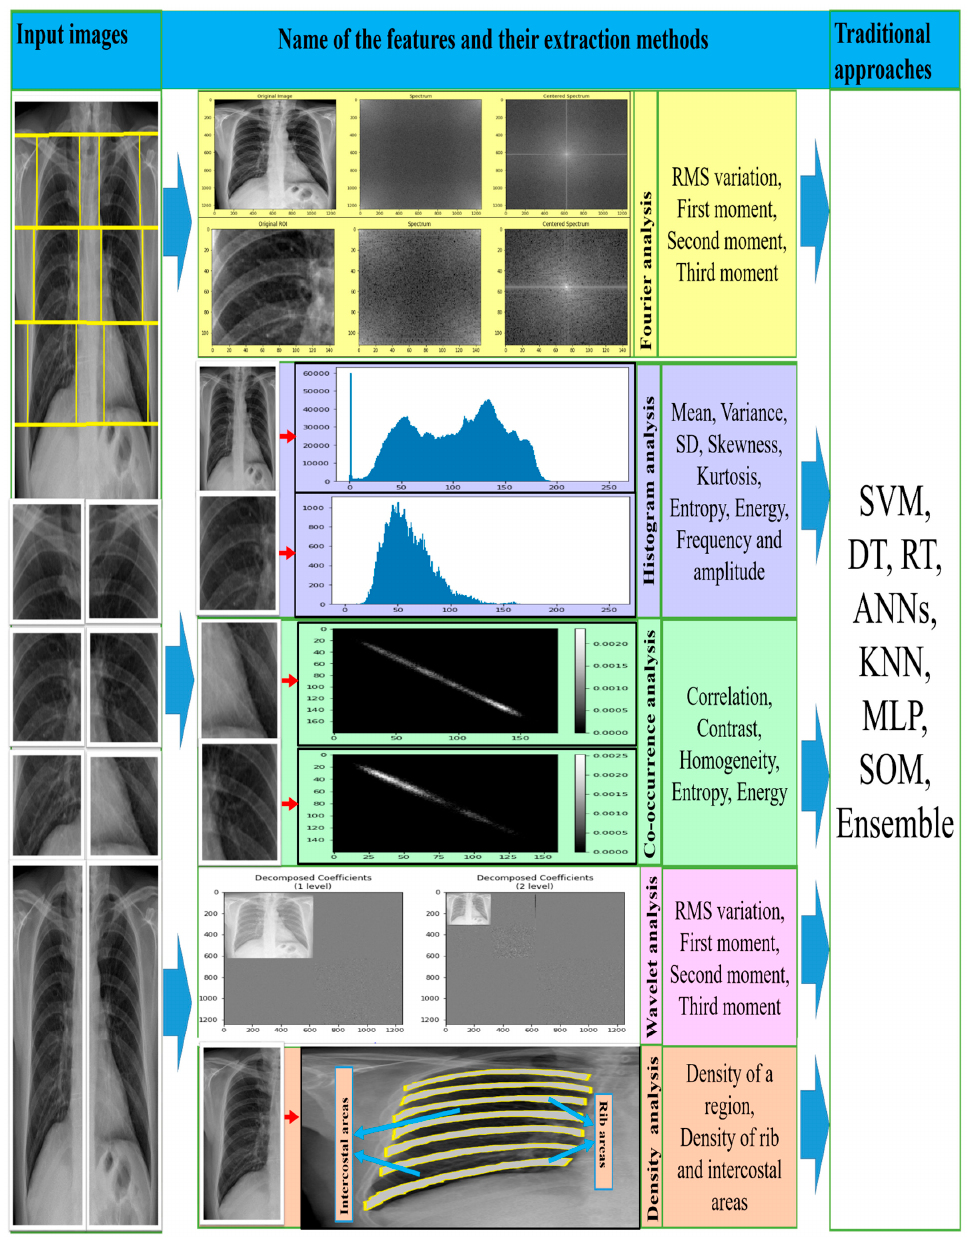
Figure 5. The illustration of the traditional approaches used for CWP detection. This review found that SVM performed best compared to the other classifiers on ROI-based texture features, which also indicated that SVM with a radial basis function (RBF) kernel is more noticeable than linear and polynomial kernel functions. The